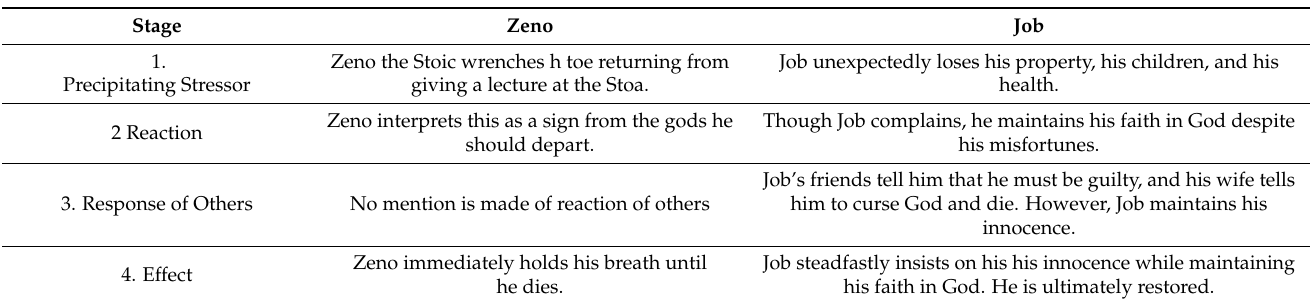
Table 5. Job against